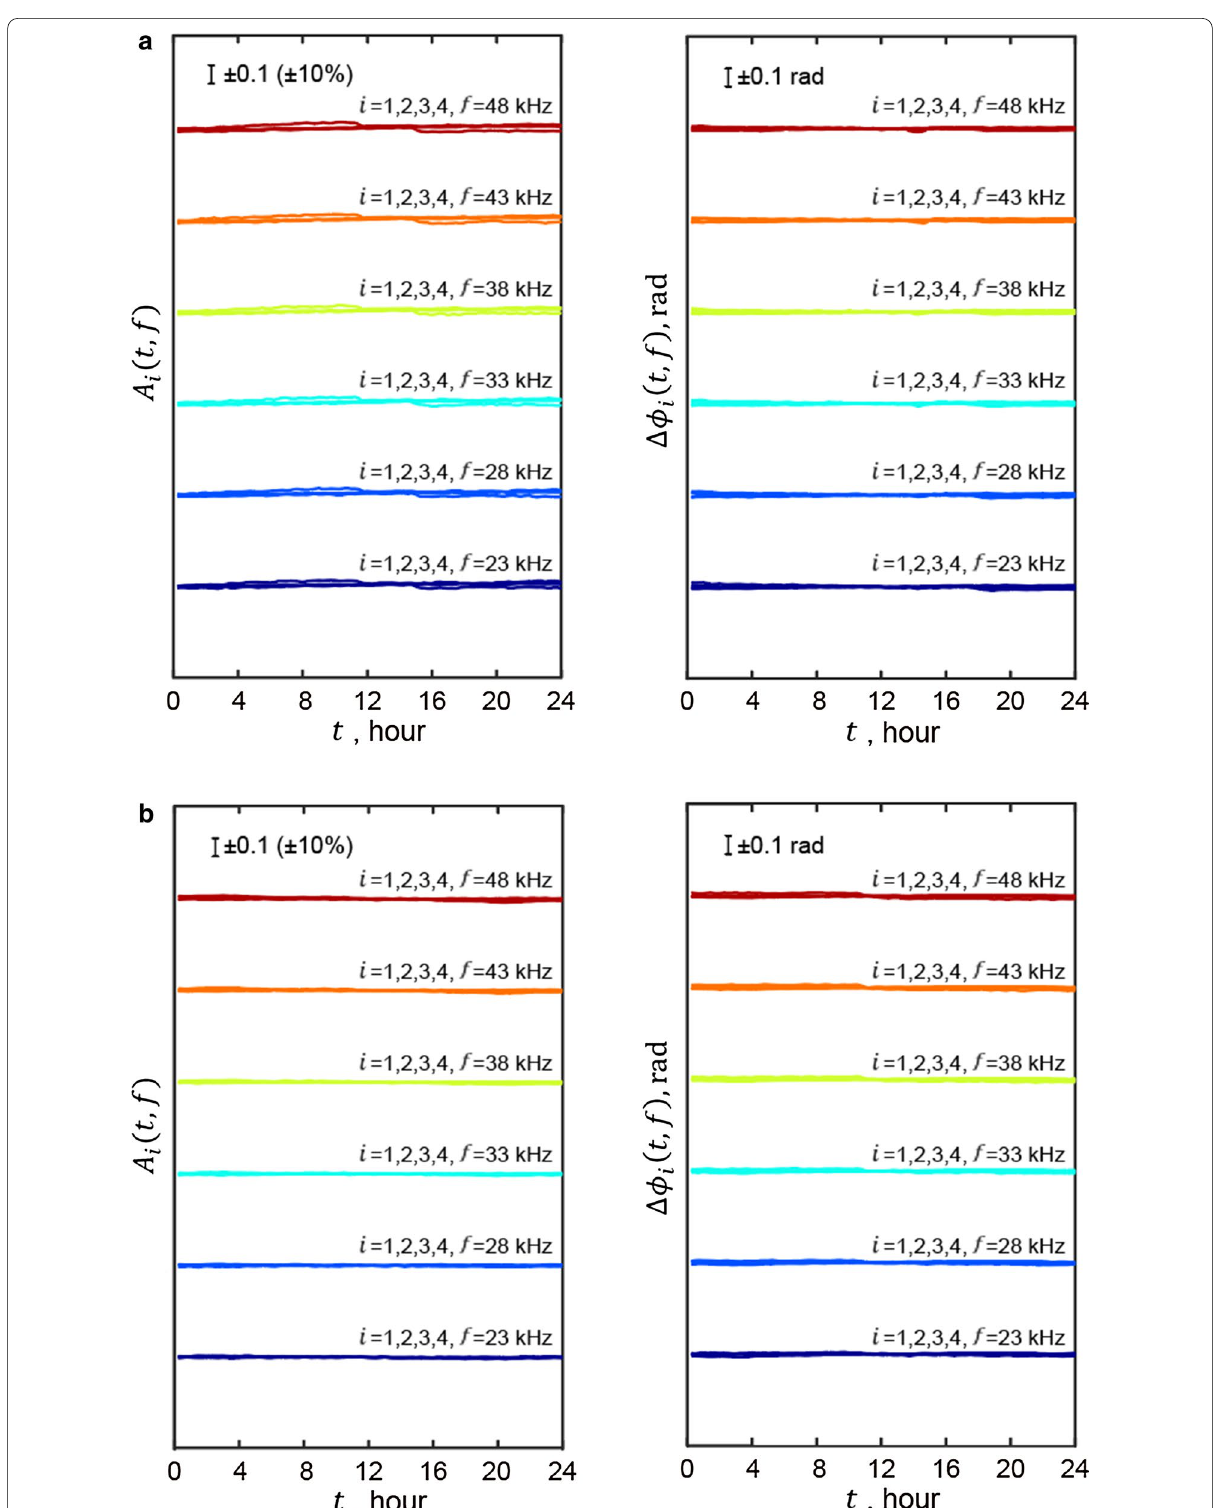
Fig. 6 Time histories of the normalized amplitude propagator and normalized phase propagator under a dry and b nearly saturated